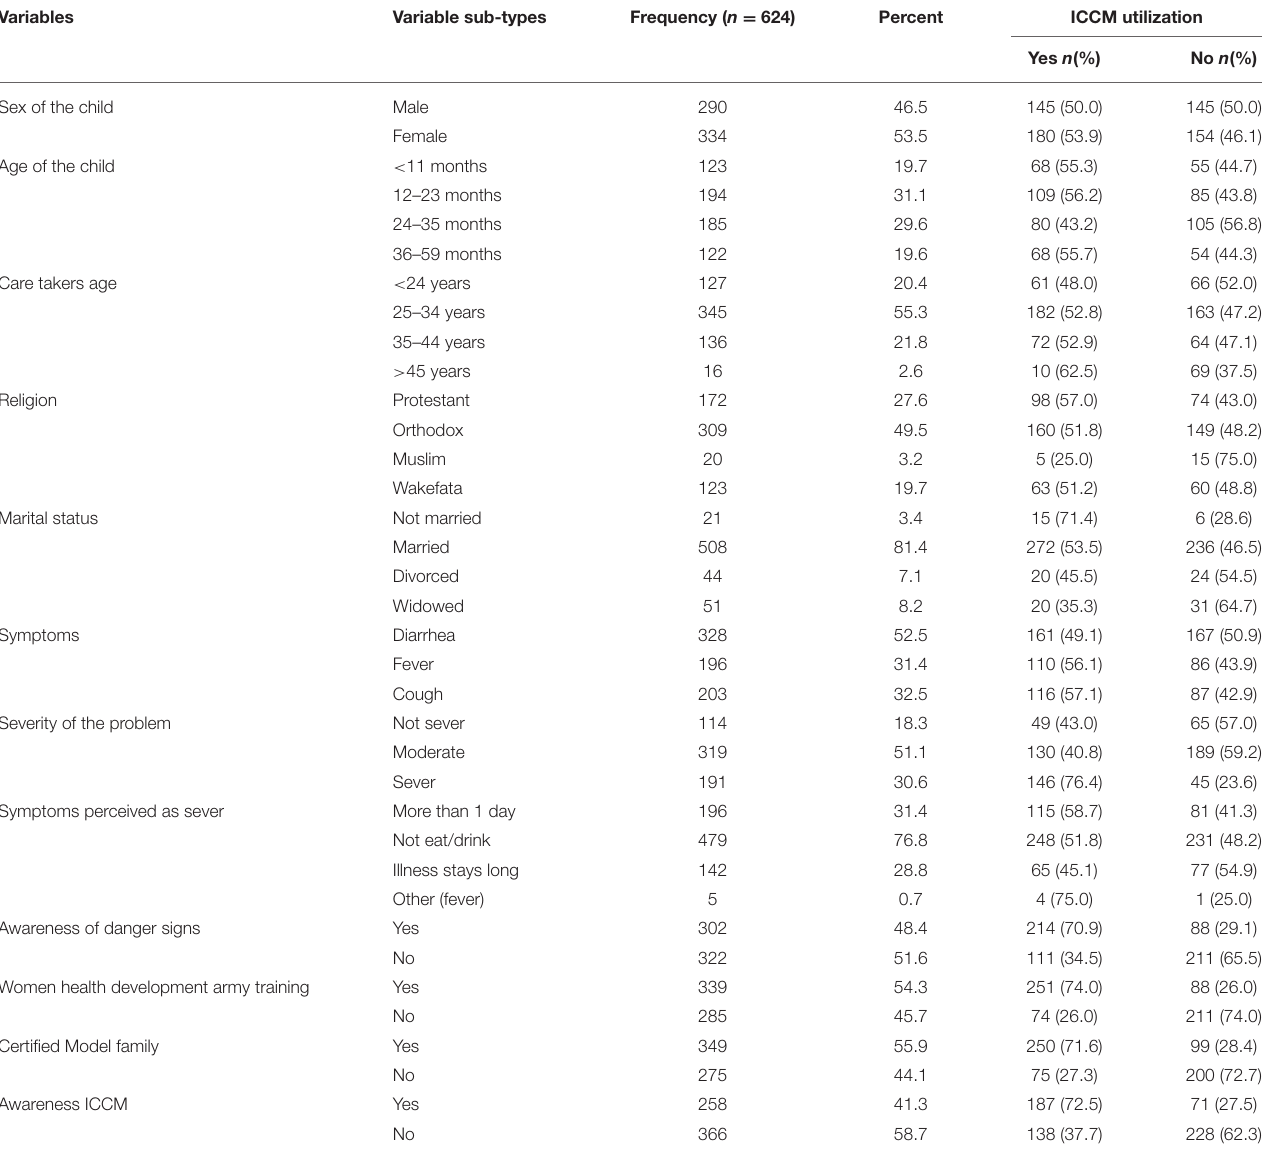
TABLE 3 | Socio-demographic and caretaker’s awareness and perception of child’s illness in ICCM utilization in Dandi woreda, West Shewa, Ethiopia,